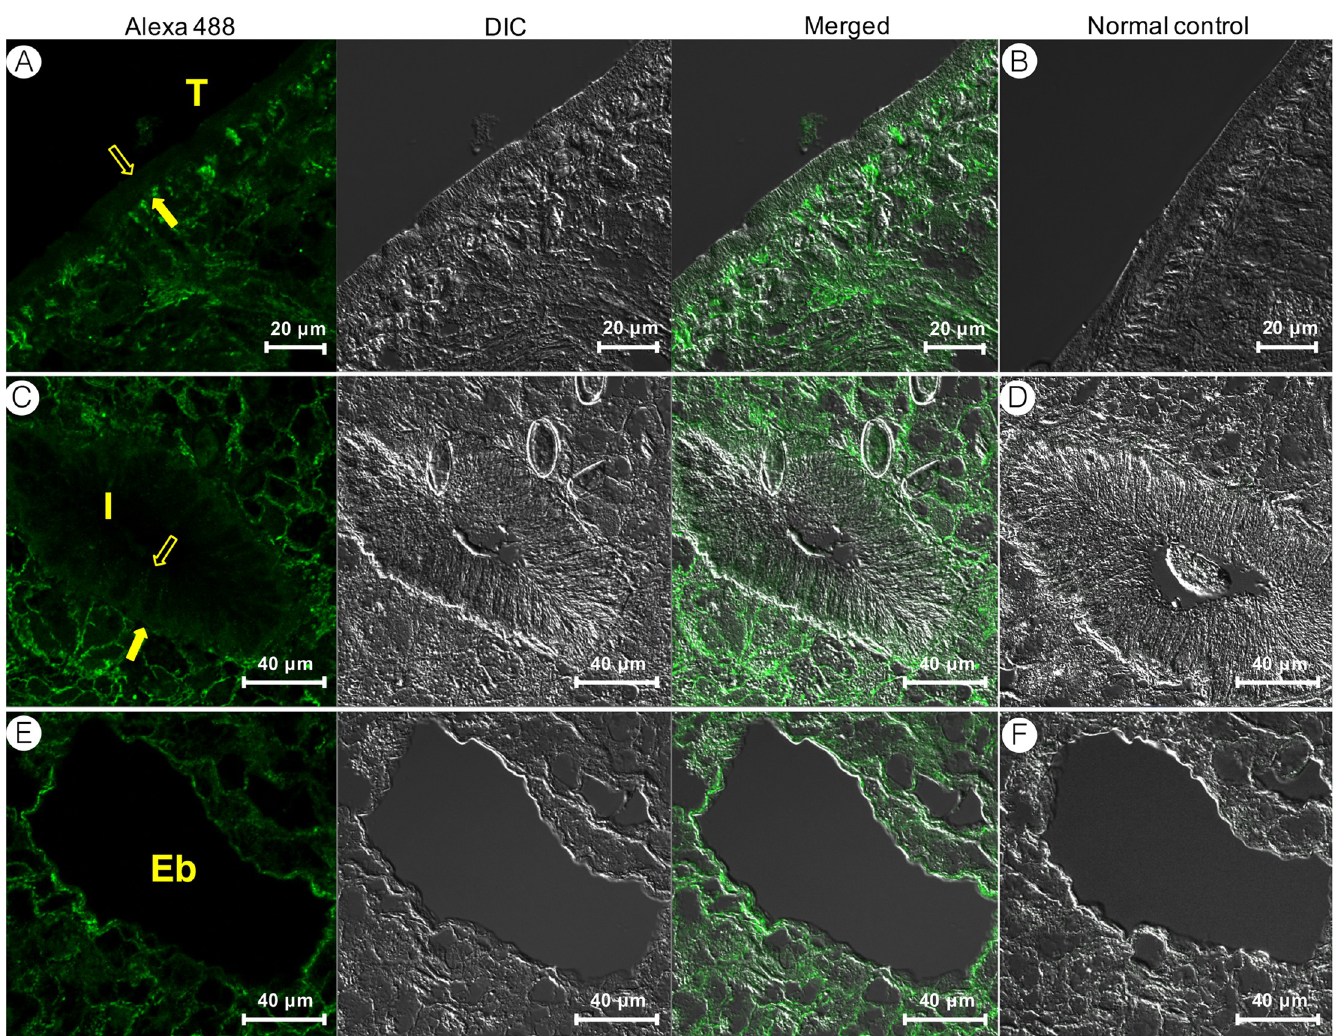
Fig 6. CsSBAT localization in Clonorchis sinensis adults using immunofluorescence staining. Left panels, mouse anti-CsSBAT immune serum; Right panels, normal mouse serum. A & B, tegument; C & D, intestine; E & F, excretory bladder. Open arrows indicate surface, and closed arrows indicate basement. Eb, excretory bladder; I, intestine; T,